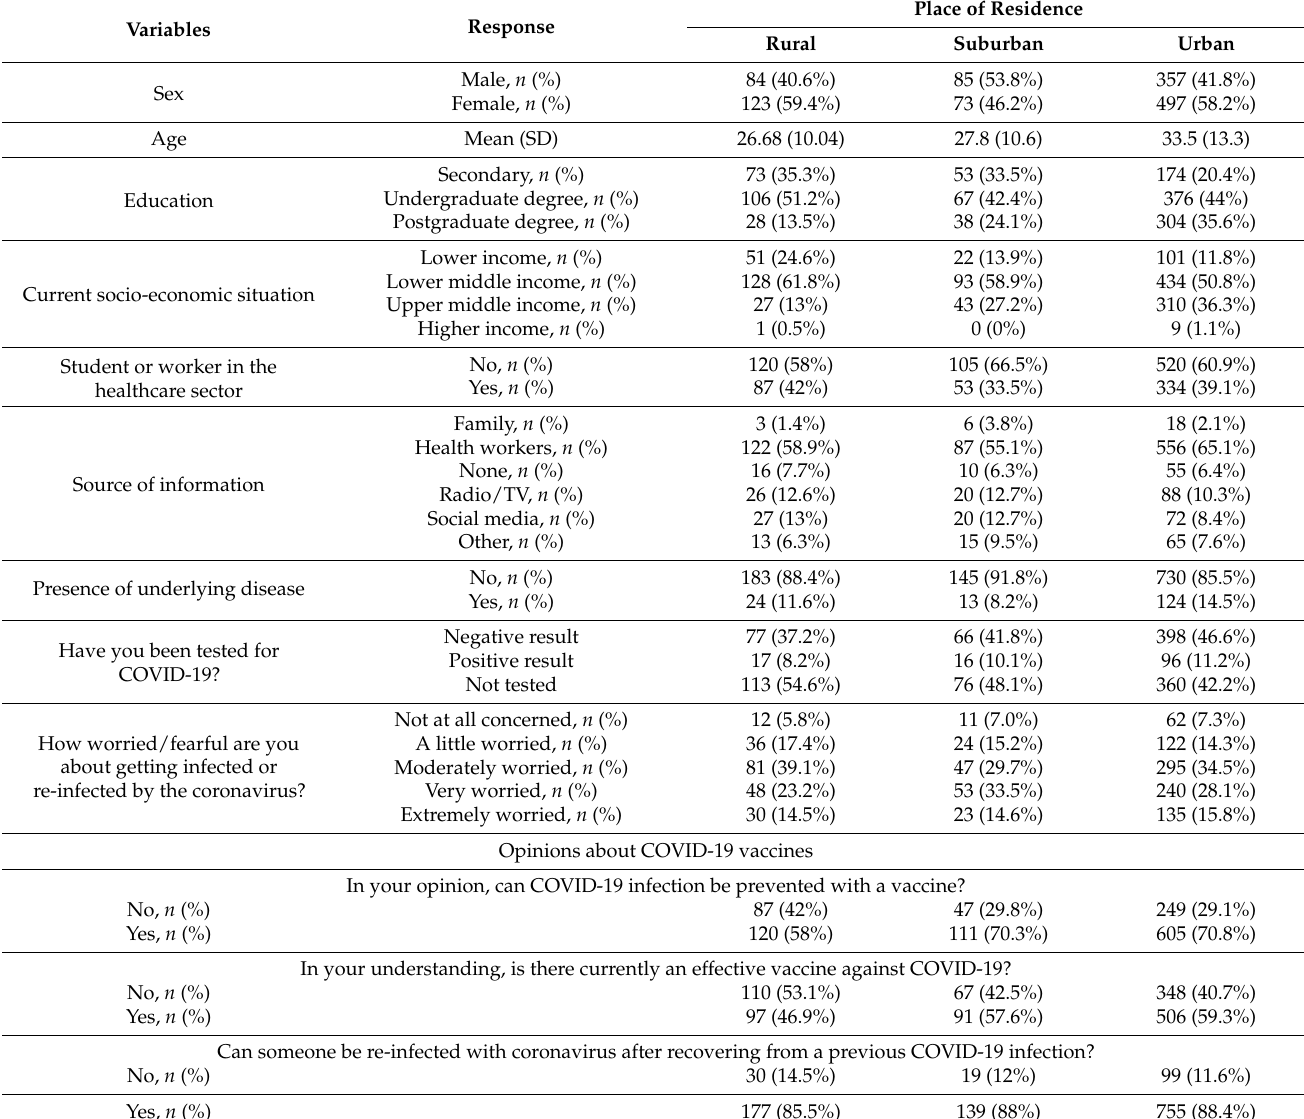
Table 1. Participants’ demographic characteristics according to place of residence and opinions about COVID-19